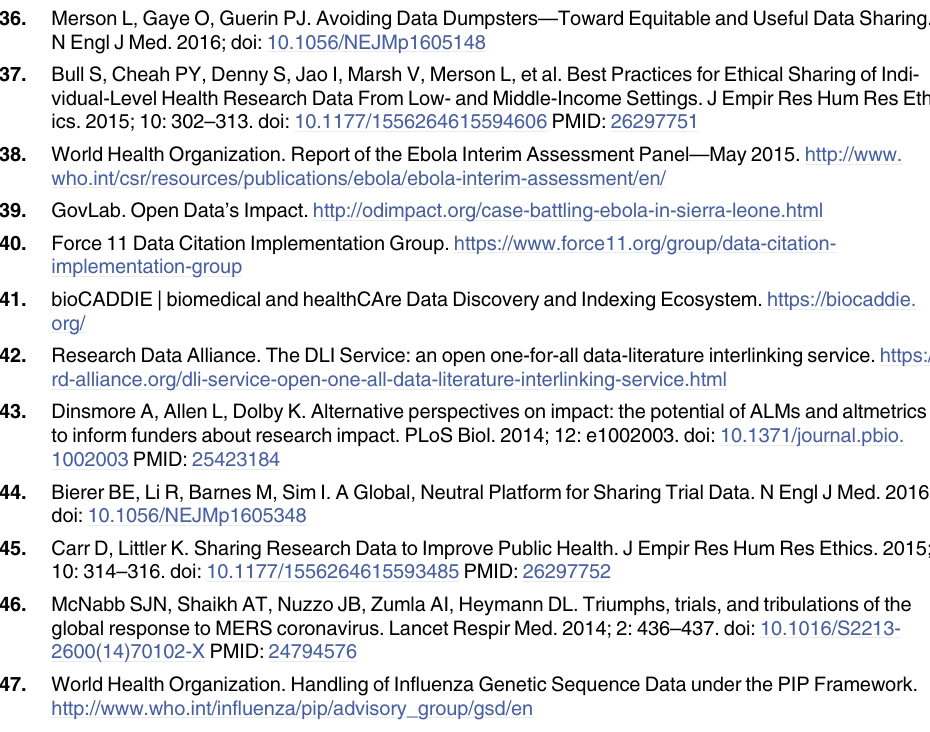
PLOS Medicine | DOI:10.1371/journal.pmed.1002109 August 16,